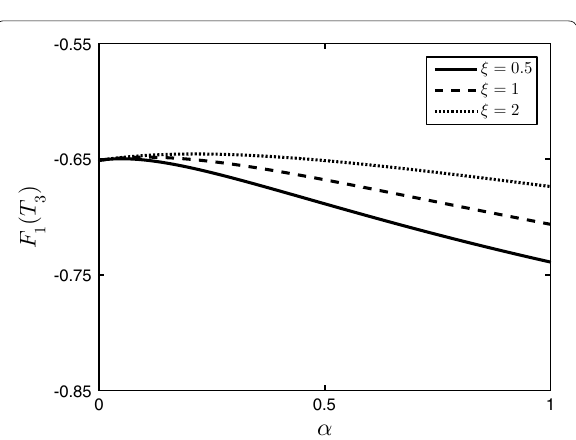
Fig. 2 Afterslip duration. The afterslip duration (80) is plotted as a function of the coupling parameter α for different values of the parameter ξ . Other parameters are ǫ V 10 − 9 =